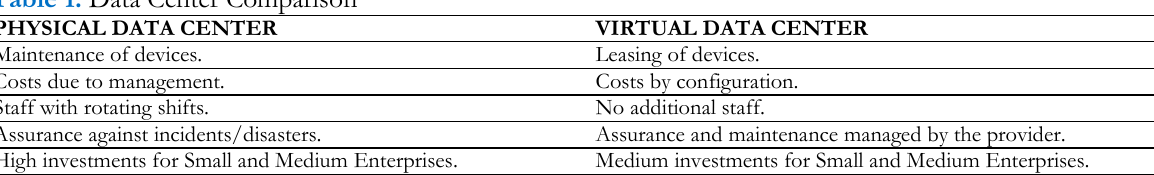
Table 1. Data Center